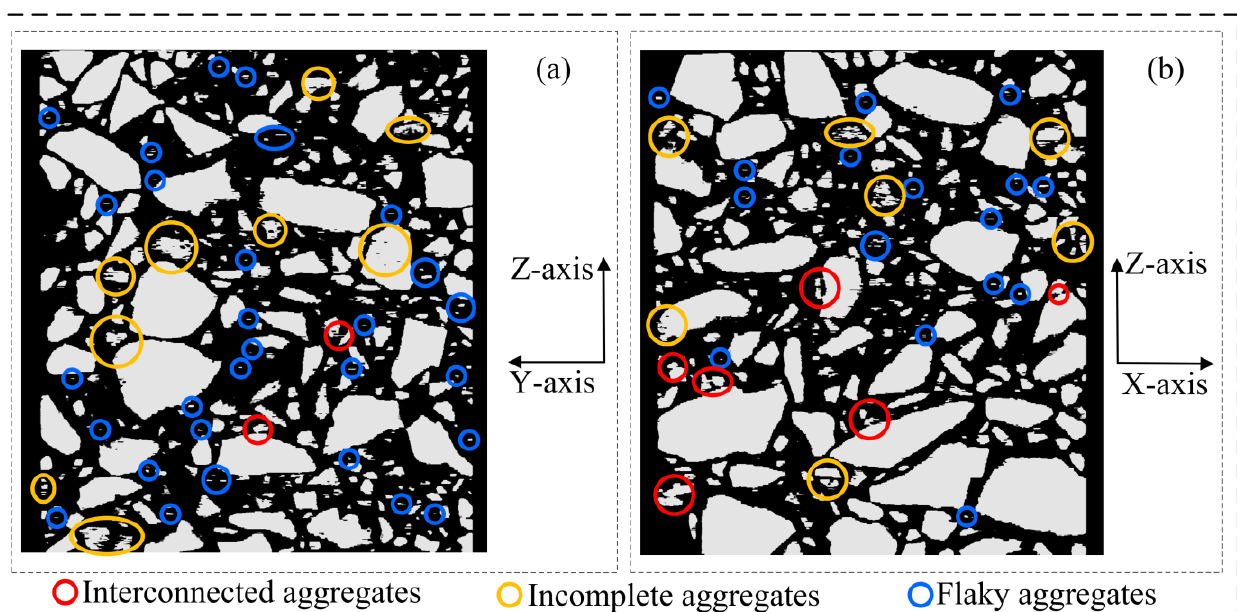
Figure 11. Asphalt concrete 3D voxel model sections (corresponding to Figure 10a): ( a ) YZ section; ( b ) XZ section.